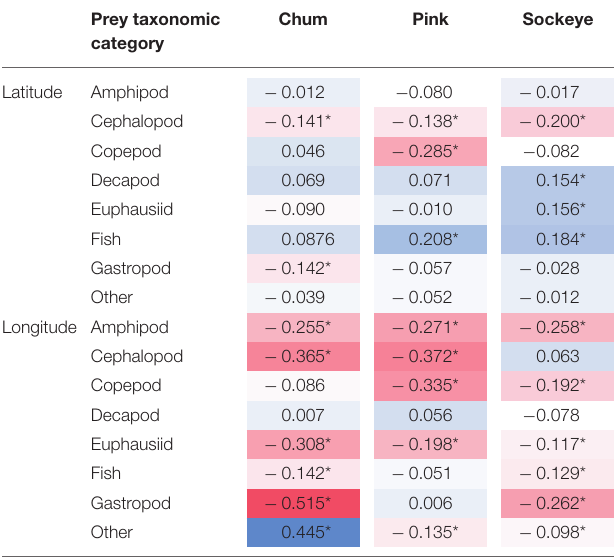
TABLE 4 | Spearman rank correlations between latitude, longitude and prey taxonomic categories for chum, pink, and sockeye. Prey taxonomic category